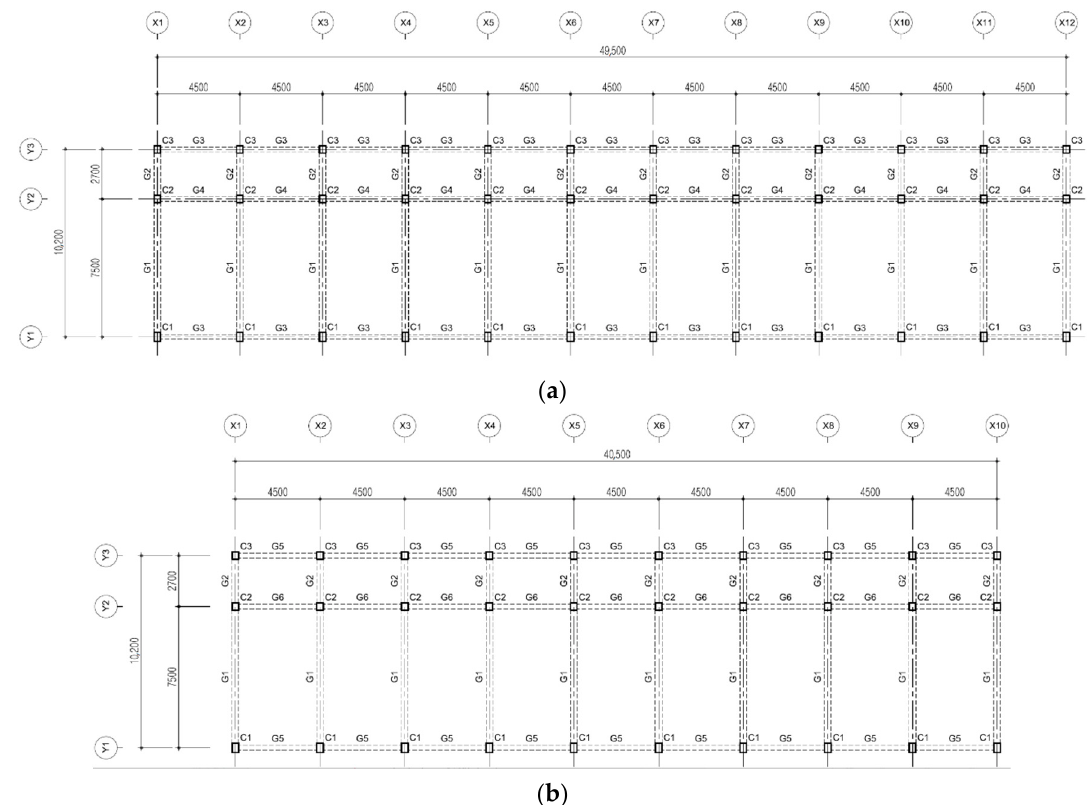
Figure 1. Typical floor plan: ( a ) Types 1 and 3, and ( b ) Type 2.